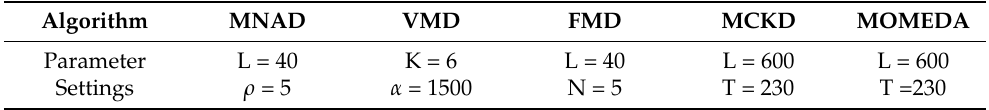
Table 5. Parameter settings for different